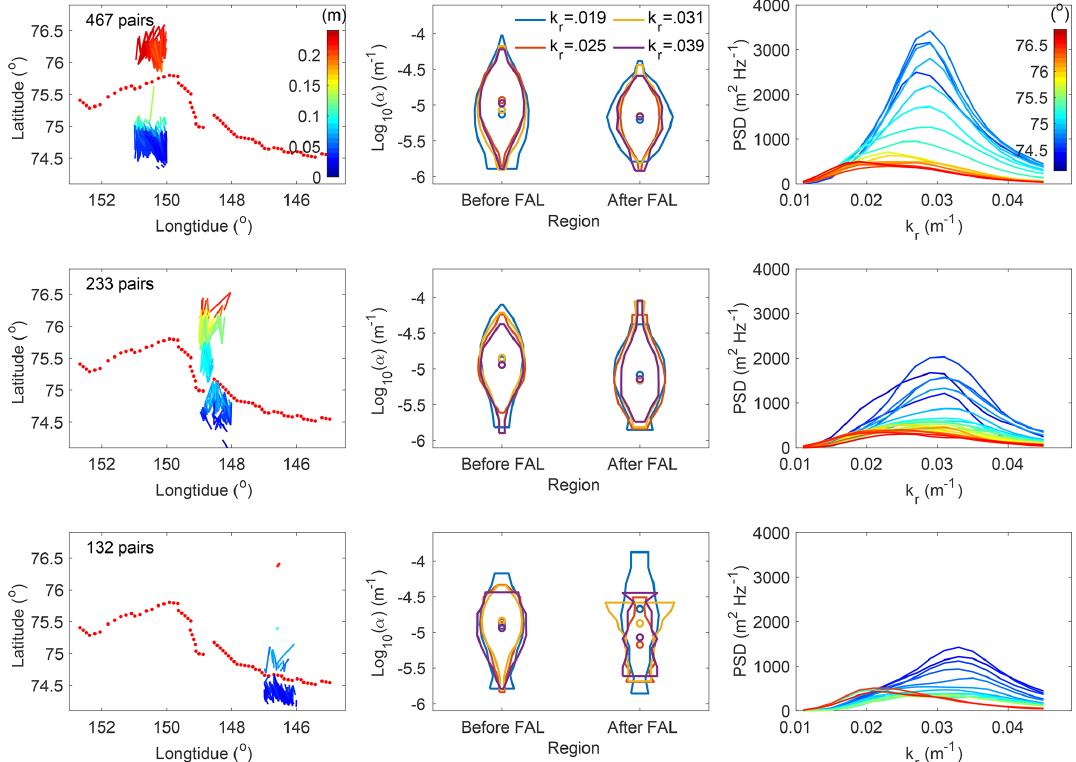
Figure 4. Close view in three selected longitude intervals: (150, 151 ◦ W), (148, 149 ◦ W) and (146, 147 ◦ W). Left column: geographical distribution of the selected pairs, each of which being represented by a segment and color indicating the mean ice thickness. Red dots represent the FAL. Middle column: violin plots of the relevant α , grouped by wave numbers and occurrence before or after the FAL. Right column: evolution of the PSD of wave spectra per 0.1 ◦ in latitude. Note that in the rightmost interval (bottom row) the red PSD curves correspond to the few very short red segments near 76.5 ◦